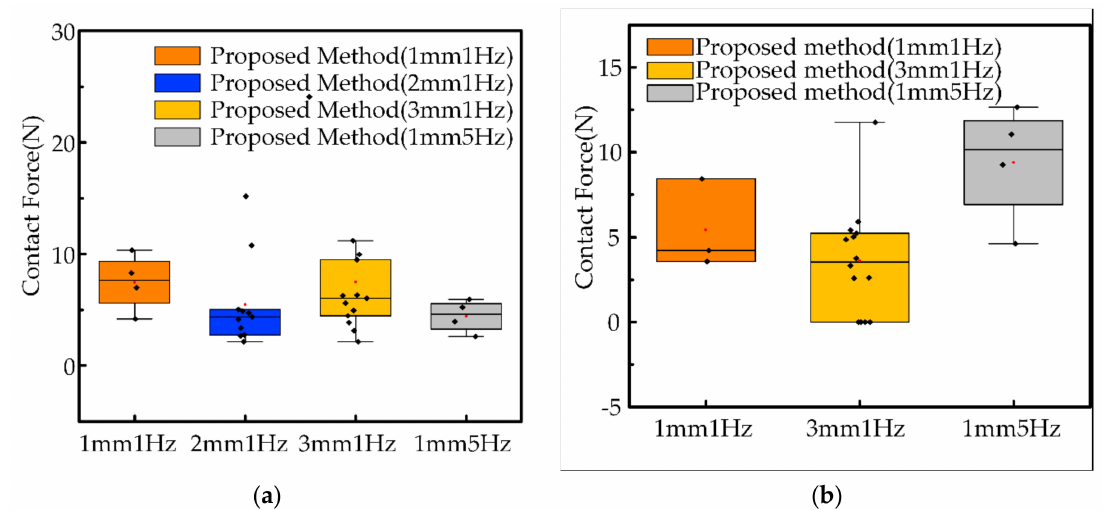
Figure 19. Results of operation of robots with different dynamic effects. ( a ) operation tool 1 and operation object 1, ( b ) operation tool 2 and operation object